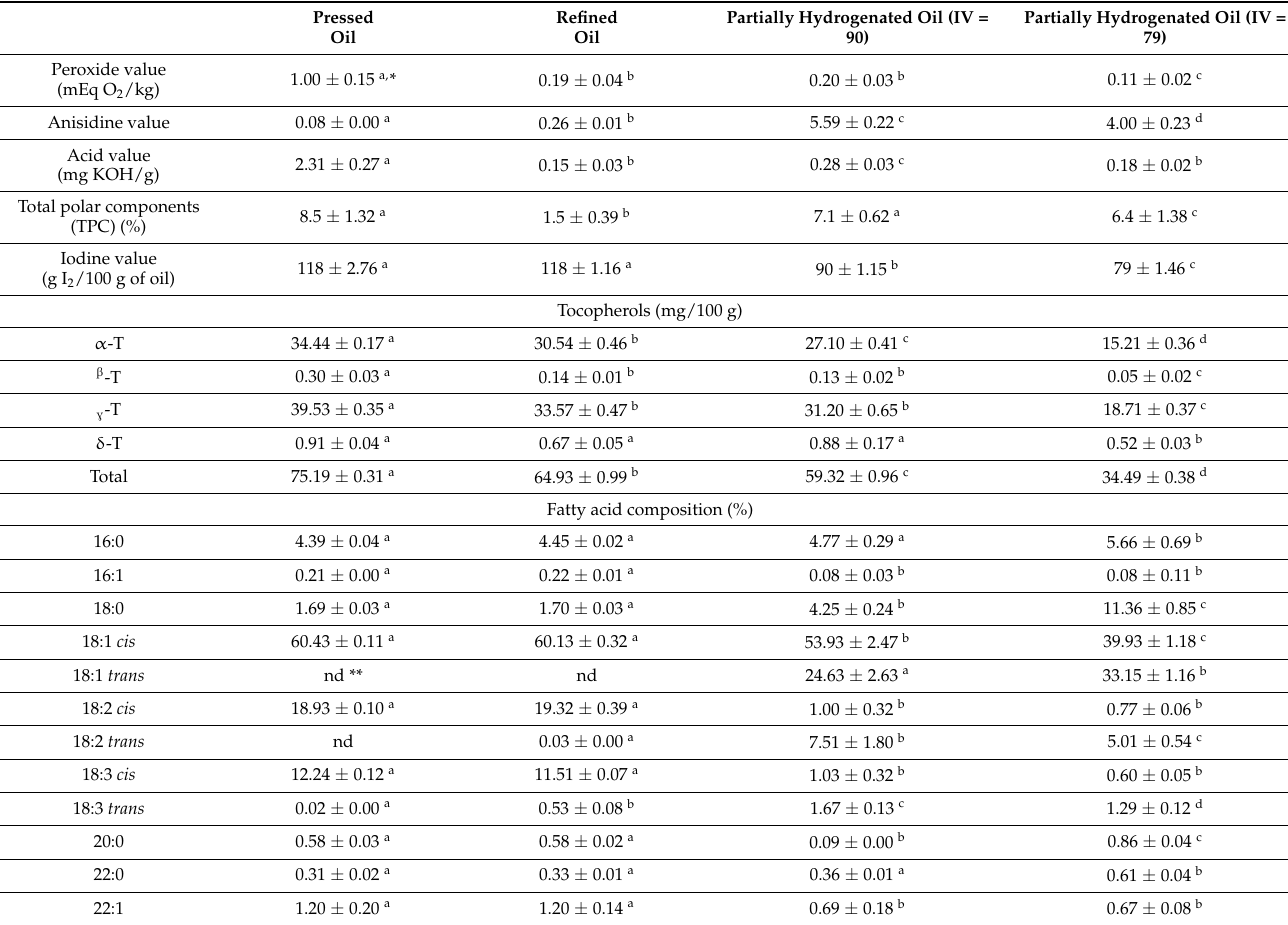
Values are means of three determinations ± SD. * Means in the same row followed by different letters indicate significant differences ( p < 0.05) between samples of each type of oil. ** nd—not detected. IV—iodine